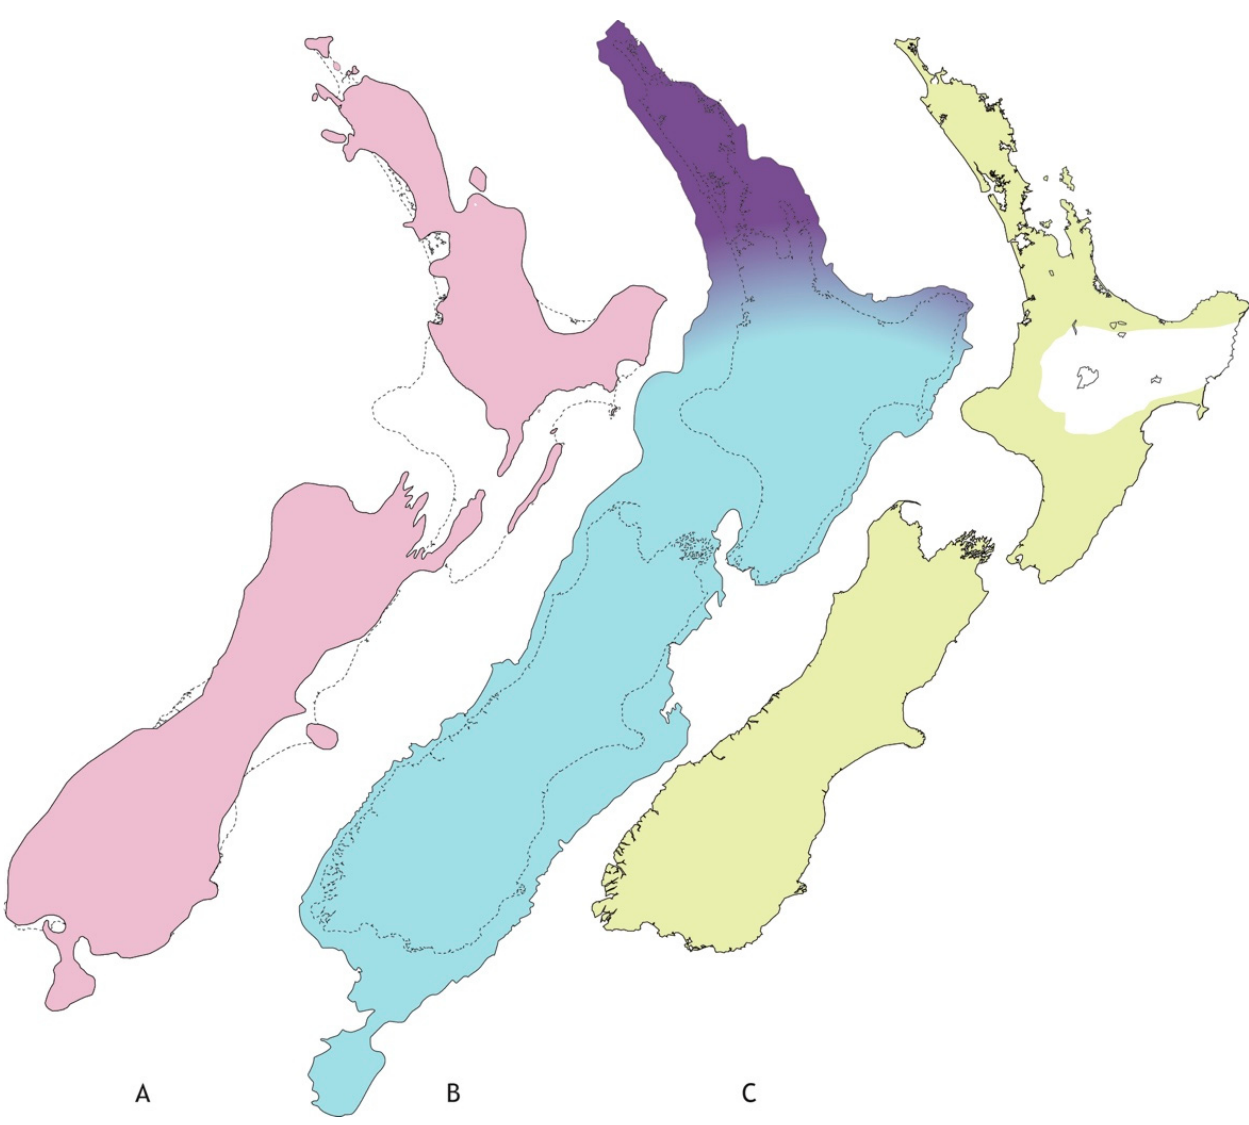
Figure 1. Approximate extent of landscape with freshwater habitat in New Zealand’s recent geological past. ( A ) Late Pliocene (~3Mya) with two main islands separated by marine strait(s) further north than today (shaded); ( B ) lowered sea level at Last Glacial Maximum of Pleistocene (~20Kya) following tectonic uplift of southern North Island (shaded), and limits of main forest in LGM (dark shading); ( C ) forest vegetation since LGM (shaded) with area impacted (white) by Hatepe eruption (1800ya). (Figure redrawn after: ( A ) [19], ( B ) [34], ( C ) [35].